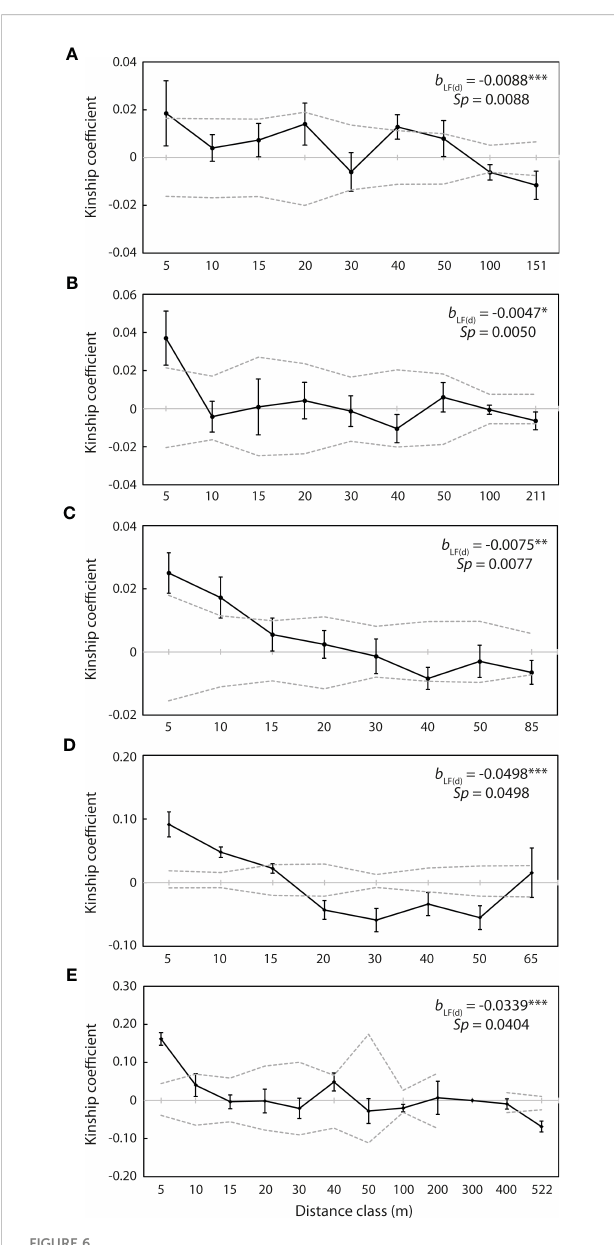
FIGURE 6 Correlograms of kinship coef fi cients ( F ij ) for individuals at the fi ve populations with more than 20 individuals. (A) WX1 (n = 56). (B) WX2 (n = 39). (C) WX3 (n = 60). (D) NPA2 (n = 40). (E) PXH1 (n = 23). Closed circles indicate mean co-ancestry values at each distance class. Dashed lines represent upper and lower 95% con fi dence envelopes around the null hypothesis of no genetic structure [ F ij (d) = 0]. b LF ( d ) represents the slope of the regression of kinship coef fi cient values, F ij ( d ), against log distance interval ( d ). Signi fi cance is indicated as *** p < 0.001, ** p < 0.01, * p <